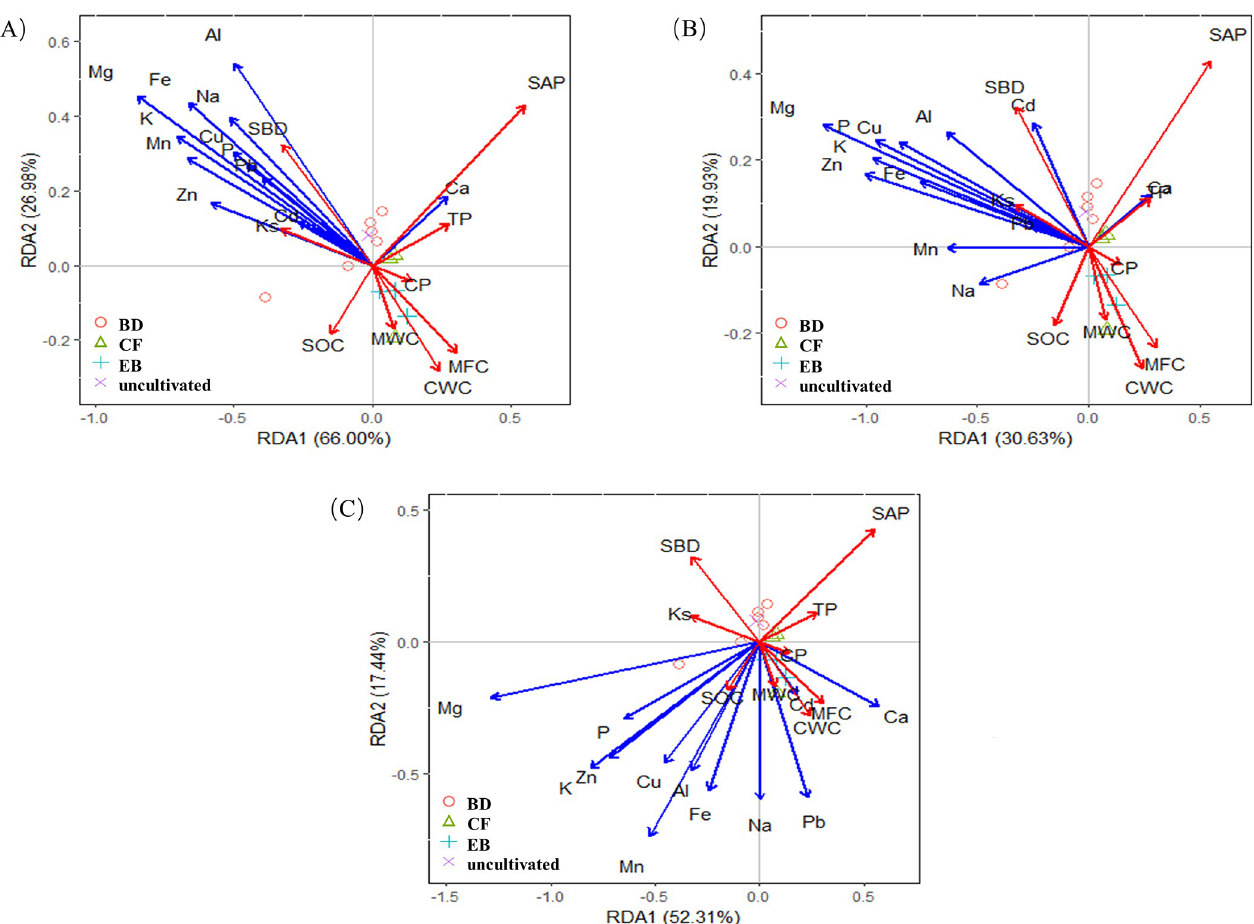
Fig 6. Redundancy analysis (RDA) results show the relationship between soil physical and chemical properties of species in different soil layers. Red and blue arrows reflect the soil physical properties and chemical properties of the RDA1 and RDA2 axis, respectively. Different vegetation types are represented by different